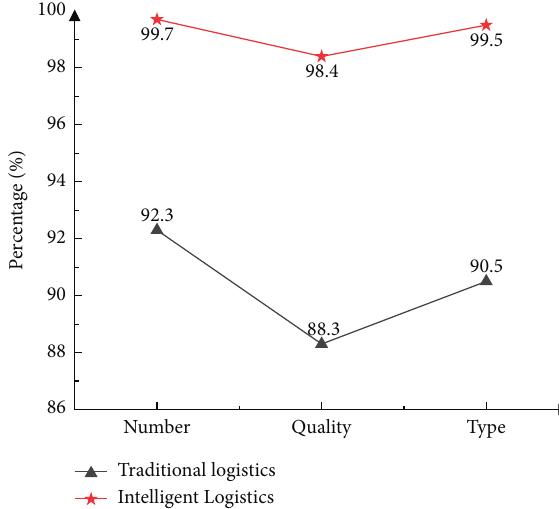
Figure 15: Comparison of the distribution accuracy.